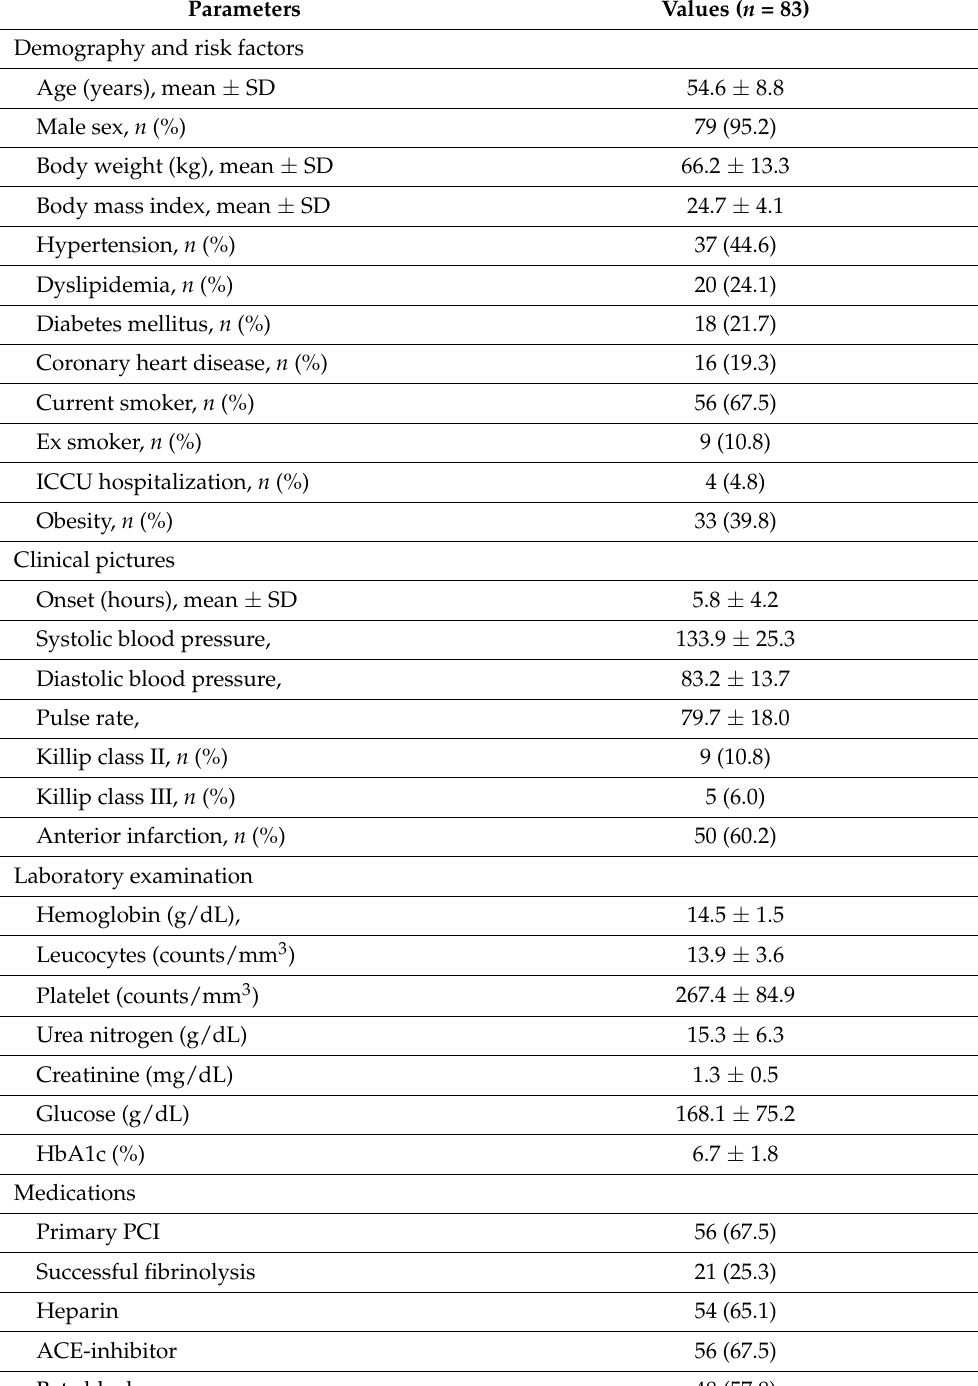
Table 1. The baseline characteristics of